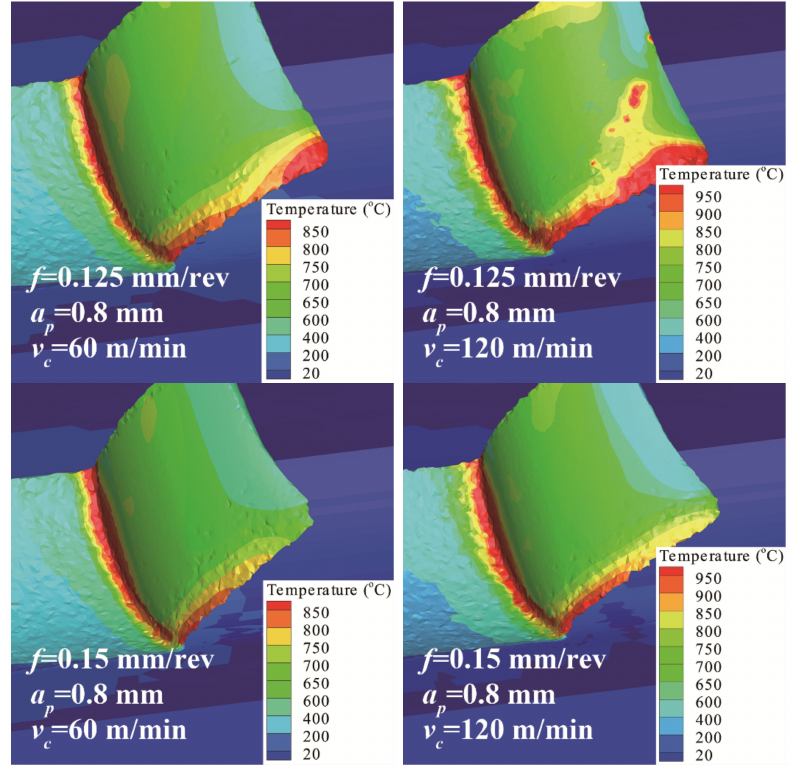
Figure A2. The temperatures of tool nose contact zone in the cutting process in the simulations.